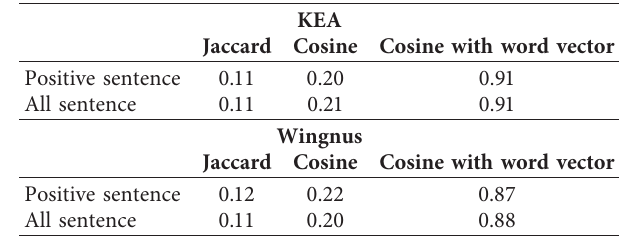
Table 2: Similarity scores calculated for different unsupervised keyword extraction